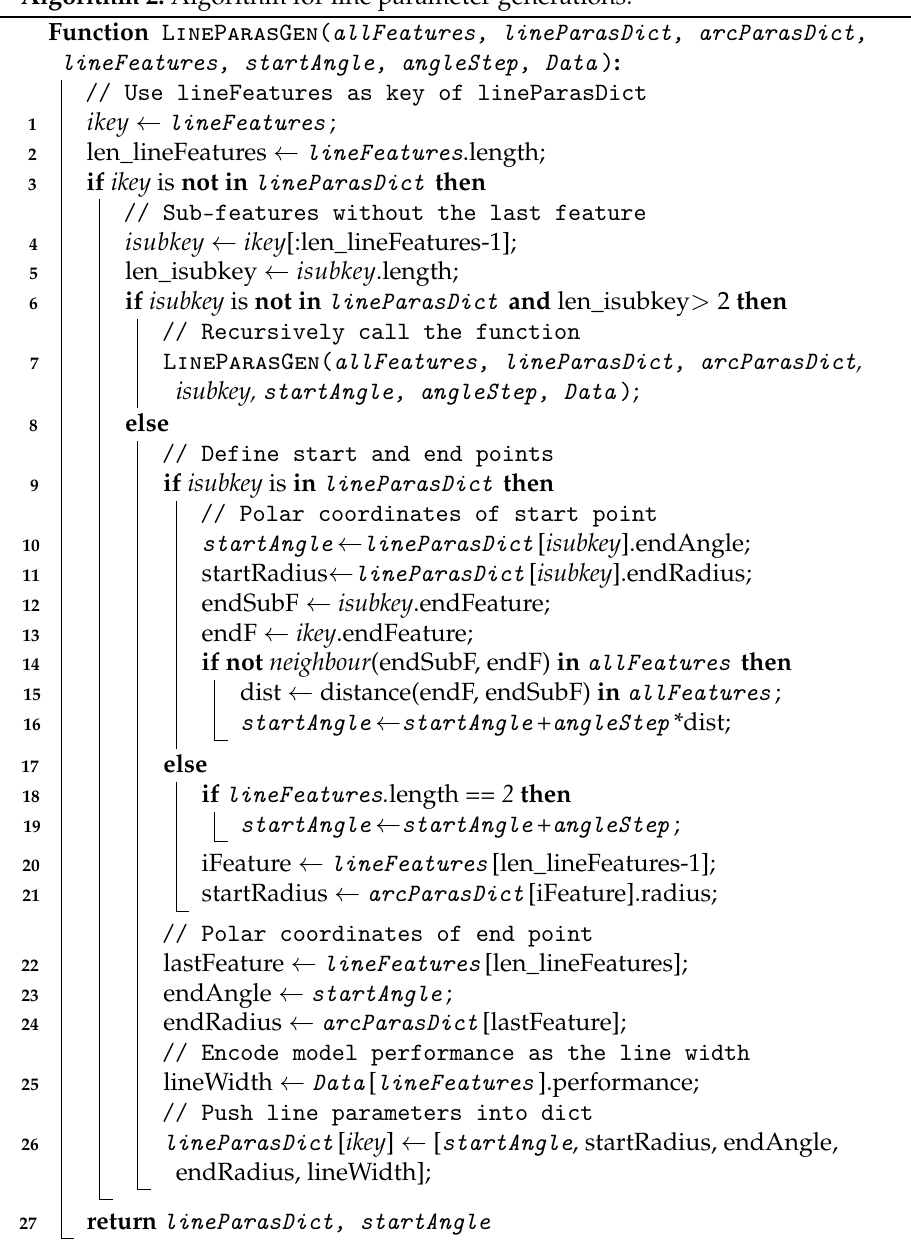
Algorithm 2: Algorithm for line parameter